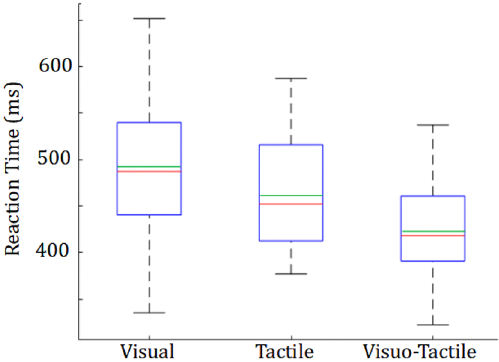
Figure 2. The average reaction time (RT) (averaged across the four directions) presented across participants during the Visual, Tactile and Visuo-Tactile conditions. A clear effect of sensory modality was observed in the results. The median is displayed in red, the mean in green and the first and third quartiles in blue. There were no outliers (non analyzed)